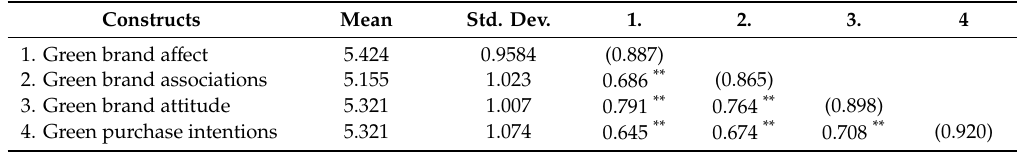
Table 2. Means, standard deviations, and correlations of the constructs.